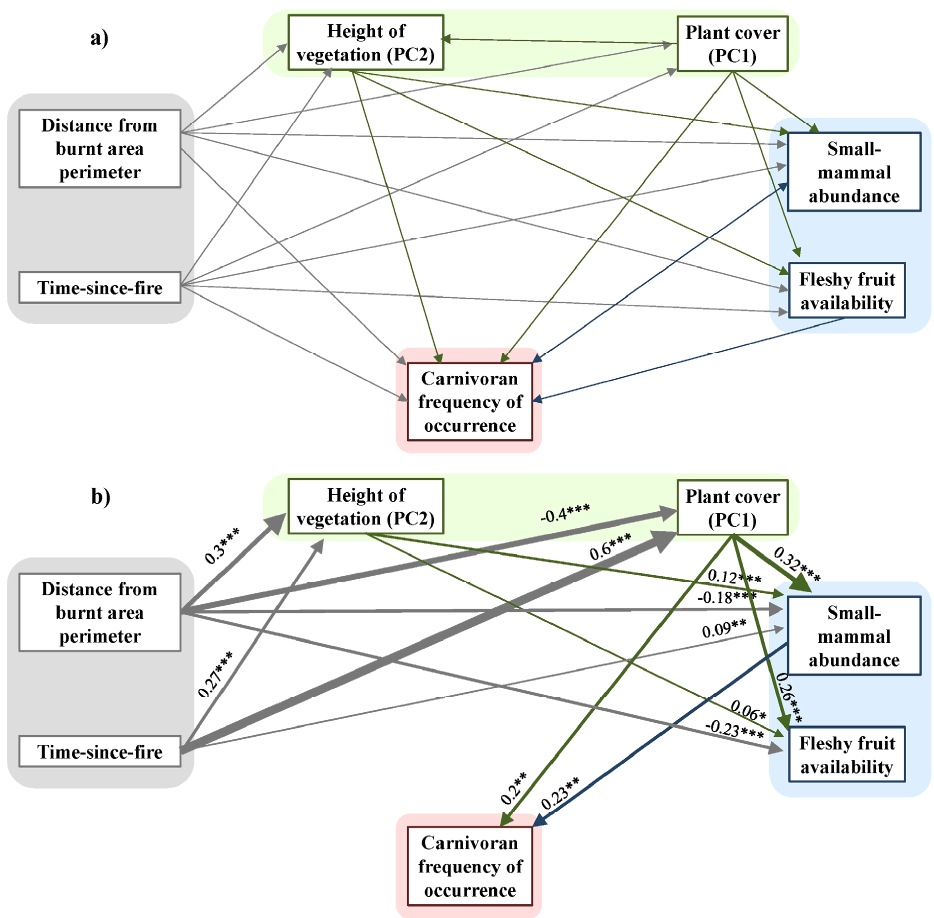
Figure 2. Most parsimonious structural equation models (SEM). Functions shown are carnivoran frequency of occurrence. All paths in the initial models (graph ( a )) were treated as optional, and were thus able to be removed during model simplification (from 27 to 22 parameters) using maximum likelihood estimation. As a final model (graph ( b )), we selected the model with the lowest AIC score. Values adjacent to paths indicate standardized direct coefficients, with significance indicated by *, p < 0.05; **, p < 0.01; ***, p < 0.001. The model was constructed using four hierarchical packages: (1) time and distance in relation to fire, (2) habitat structure (first two PCA axis), (3) food availability, and (4) carnivoran occurrence. One-way arrows represent paths between